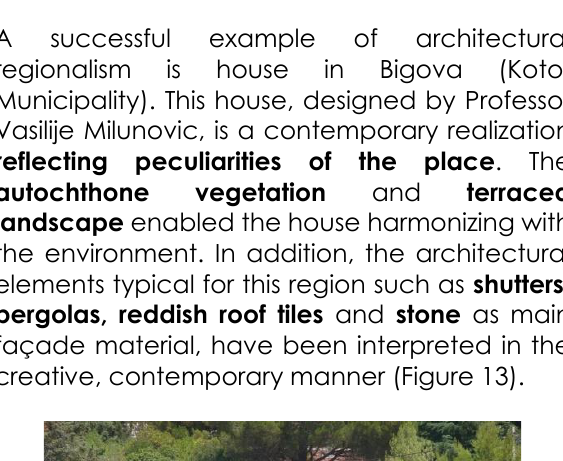
Figure 12. Design guidelines- retaining walls (Source: Lalosevic, 2010)